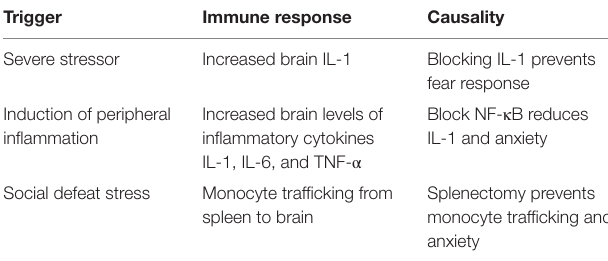
TABLe 2 | Overview of studies with animal models of PTSD that provide a causal immune–PTSD